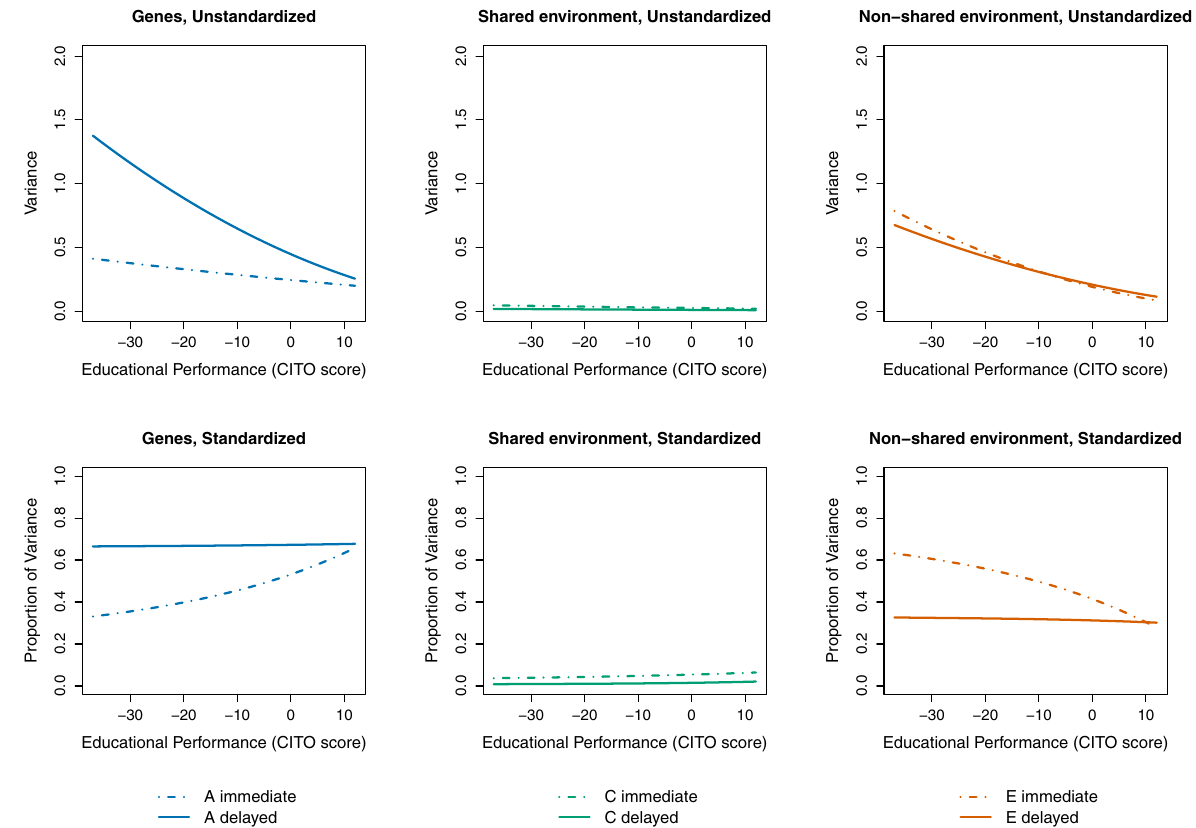
Fig. 2 The unique genetic and environmental variances of educational attainment for immediate versus delayed tracking as moderated by educational performance. Unstandardized variances shown in the top panels and standardized variances in the bottom panels. Genetic variance shown in the left, shared environmental variance in the middle, and non-shared environmental variance in the right panels. Educational performance (CITO) scores on the x-axis are